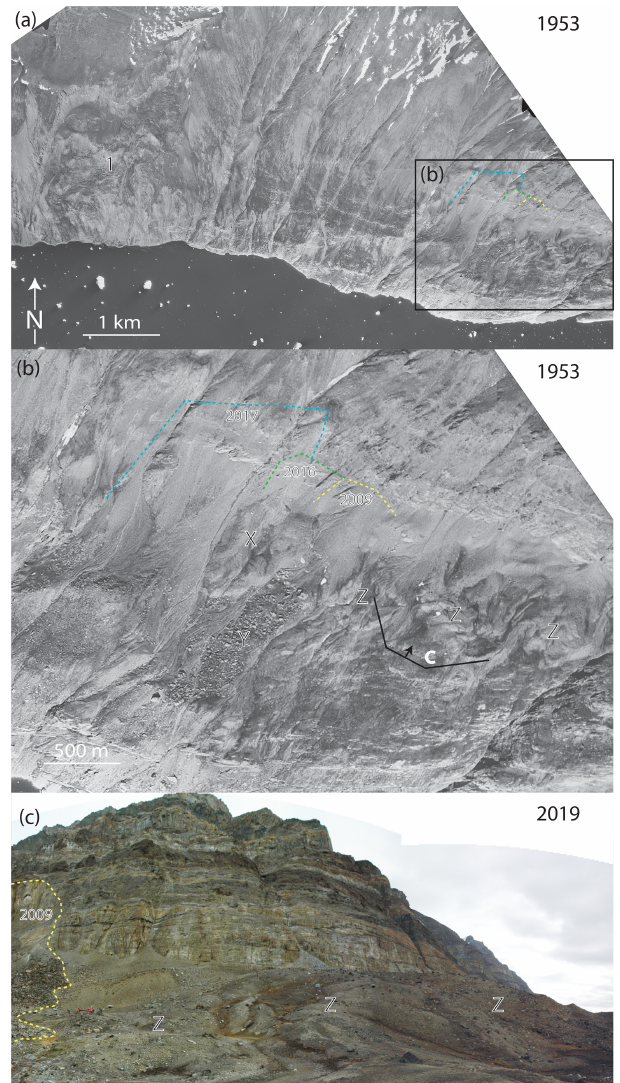
Figure 2. Previous activity in the Karrat Landslide Complex. (a) 1953 1 : 45000 scale aerial photograph of the Karrat Landslide Complex showing the well-developed state of the unstable rock slope; area 1 is to the W. The three stippled lines to the east show the positions of the scarps of the future rock avalanches (colours match Fig. 1b). (b) Details of (a) with the stippled lines indicating the positions of the scarps of the future rock avalanches. Notice the lobate morphology (X) and boulder field (Y) indicating older rock slope failures along with the hummocky topography to the E (Z). (c) Photomosaic of field photos from the summer of 2019 taken just E of the 2009 rock avalanche. The scarp and lobe of the 2009 rock avalanche are indicated with a stippled yellow line. The lobate hum- mocky topography interpreted as being deposits of past rock slope failures is indicated with (Z). Red helicopter for scale.